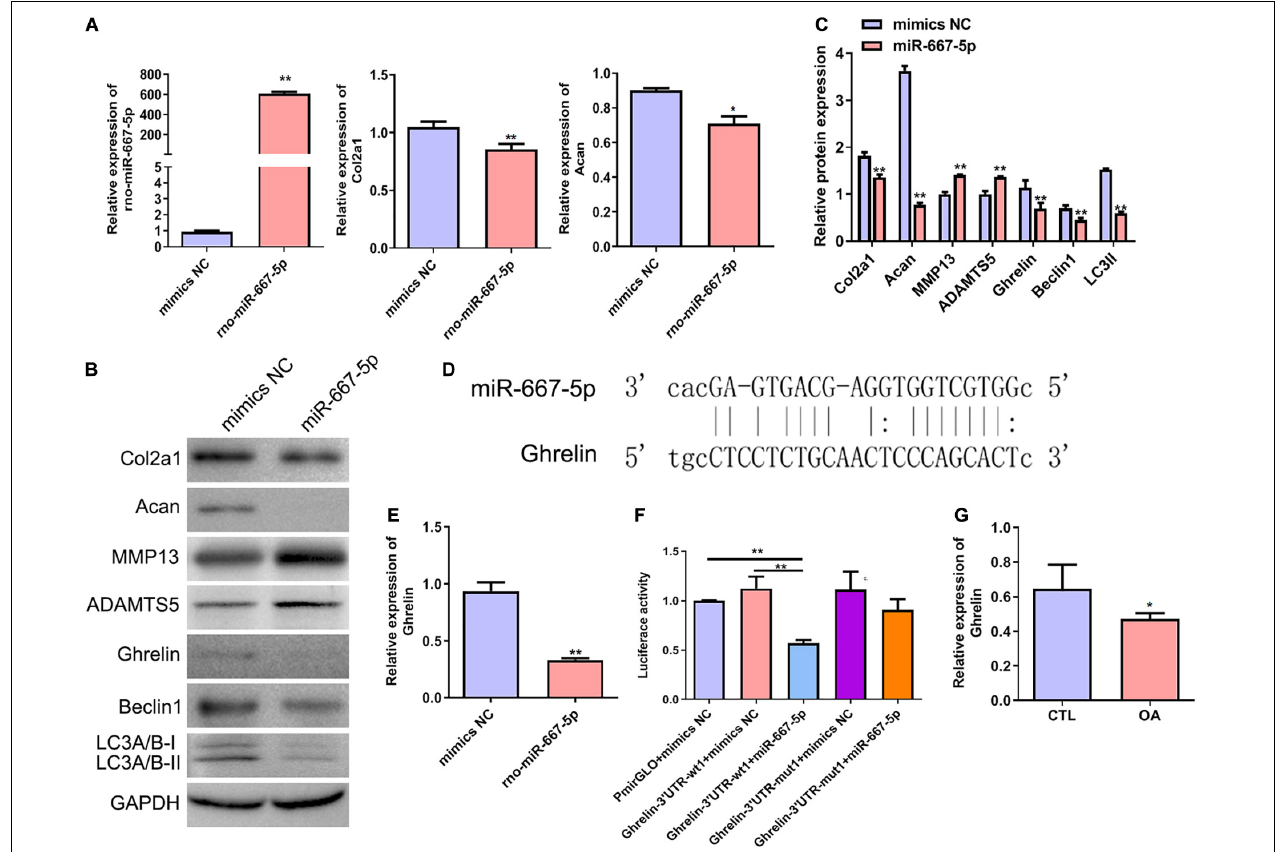
FIGURE 6 | miR-667-5p inhibited autophagy and promoted OA progression likely by targeting ghrelin gene in chondrocytes. (A) Expression levels of miR-667-5p, Col2a1, and Acan in rat chondrocytes transfected with mimics NC or miR-667-5p mimics. The relative levels of miRNAs and mRNAs were determine using RT–qPCR. (B) Western blotting results of Col2a1, Acan, MMP13, ADAMTS5, ghrelin, beclin 1, and LC3 in rat chondrocytes transfected with mimics NC or miR-667-5p mimics. (C) The quantitative analysis results of western blotting shown in (B) . (D) Binding site between miR-667-5p and the ghrelin gene 3 (cid:48)